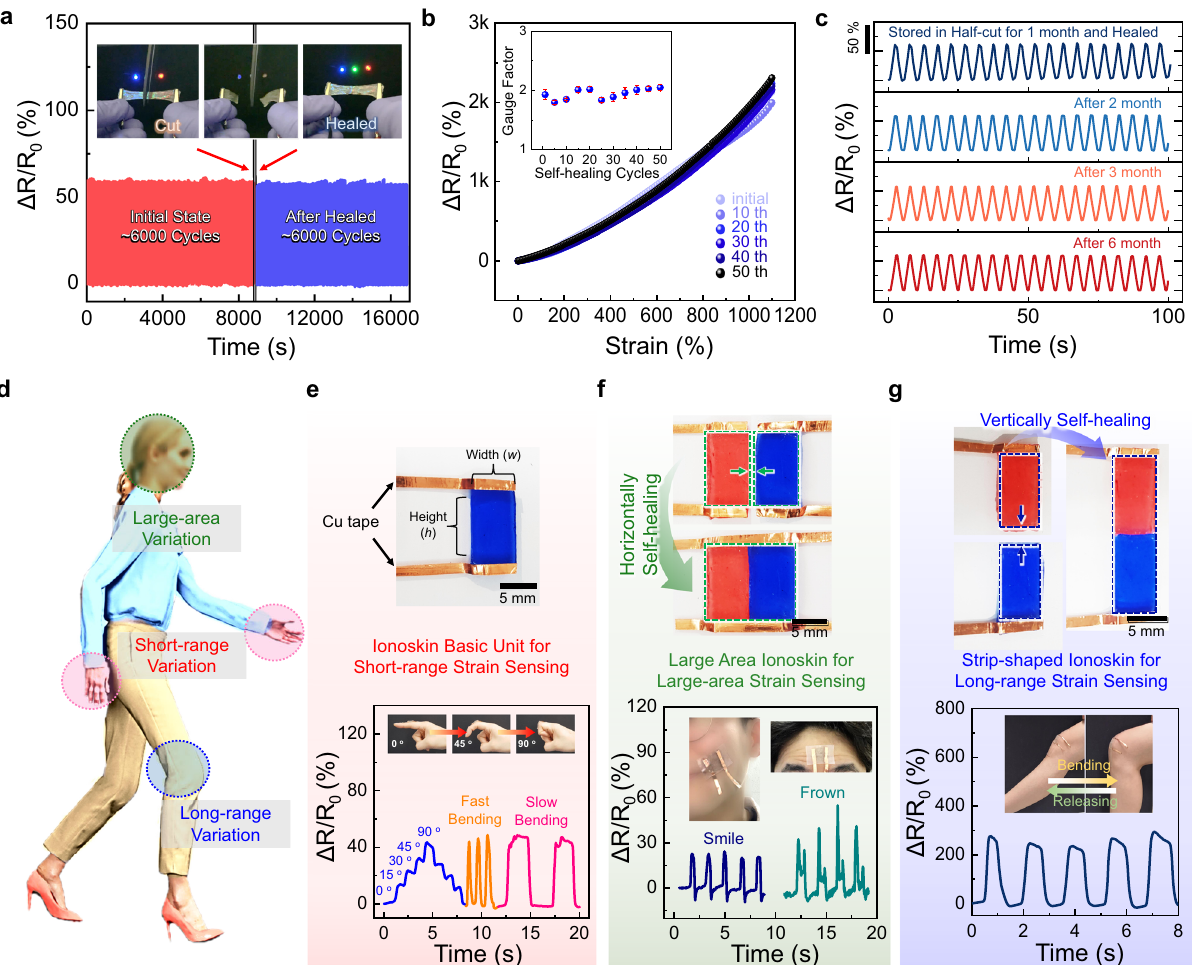
Fig. 3 Mechanical/electrical self-healing of ionoconductors and applications in area-adjustable ionoskins. a Cyclic stability tests of 92-AAHA-IL-based ionoconductor during 6000 initial cycles before mechanical damage and 6,000 additional cycles after being healed. The inset images represent the state of the ionoconductor during cutting and healing through the on/off state of LEDs. b Strain-dependent resistance changes ( Δ R / R 0 ) during cut and healing cycles. The inset indicates the variation in gauge factor as a function of self-healing iterations. Error bars indicate standard deviation. c Stable IC-mediated self-healing process of 92-AAHA-IL, for which two pieces of the ionoconductor were kept under ambient conditions for up to 6 months and healed prior to the cyclic test. d Schematic illustration of various cases according to strain variation and range when applying to ionoskins. e Image of ionoskin basic unit colored blue for easy identi fi cation (top) and tracking of various fi nger motions (bottom). f Large-area ionoskin prepared by self-healing along the height direction (top) to monitor facial skin deformations (bottom). g Fabrication of strip-shaped ionoskin (top) and its use for detecting long-range strain variations